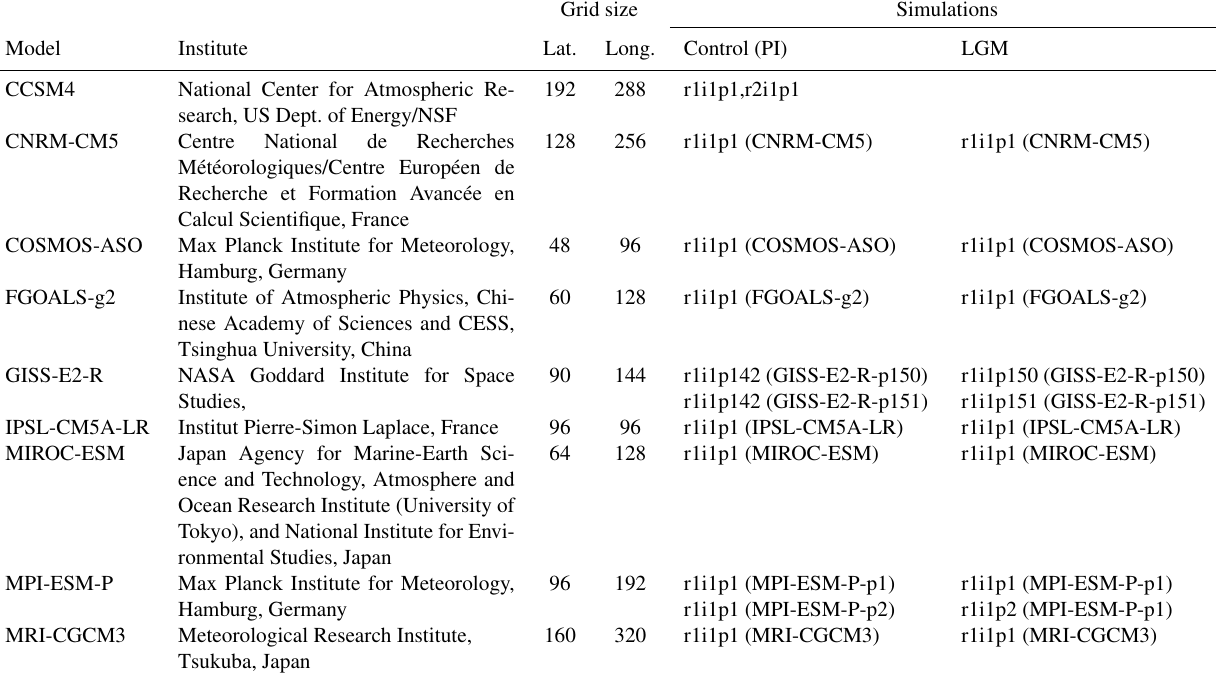
Table 1. List of all CMIP5-PMIP3 simulations used in this study. The individual simulations (r <N > i <M > p < L > ) formatted as shown below (e.g. “r3i1p21” with r for “realisation”, i for “initialization method indicator”, and p for “perturbed physics”) distinguishes among closely related simulations by a single